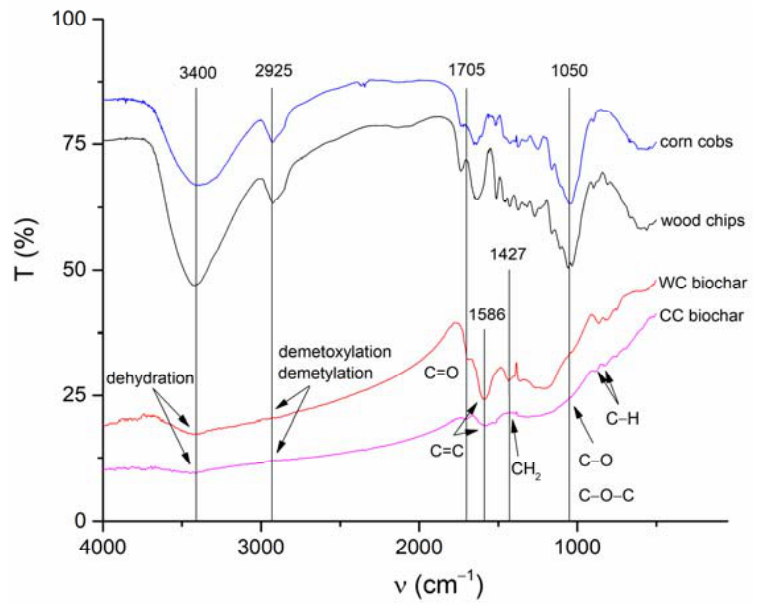
Figure 4. Fourier-transformed infrared bands characterizing surface functional moieties of both corn-cob and wood-chip feedstock and CC and WC biochars.